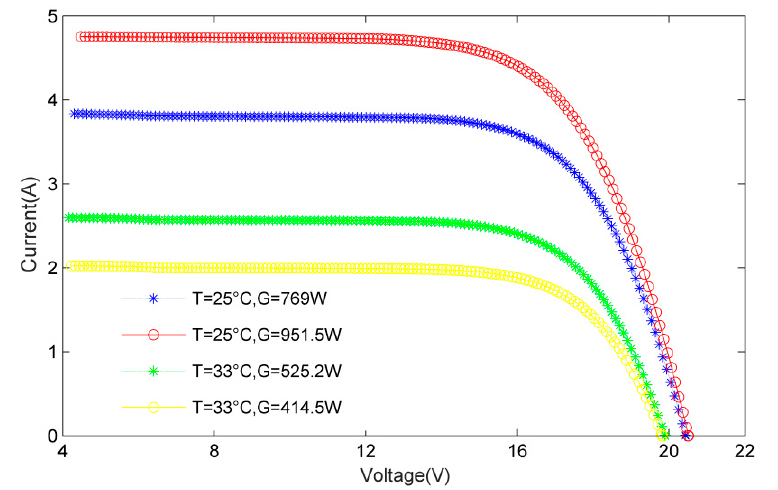
Figure 2. Current characteristics for different T and G.